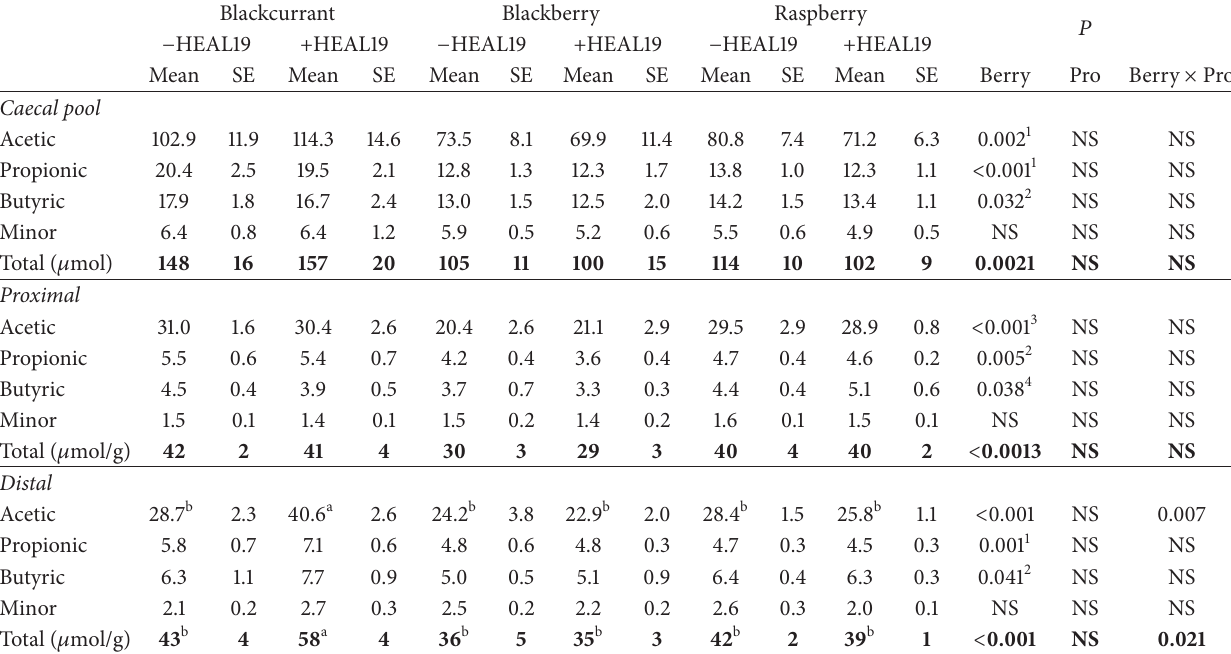
Table 4: Short-chain fatty acids in caecum ( 𝜇 mol/caecal content) and proximal and distal colon ( 𝜇 mol/g) of rats fed diets containing blackcurrant, blackberry, and raspberry, with the same diets supplemented with L. plantarum HEAL19. Blackcurrant Blackberry Raspberry 𝑃 −